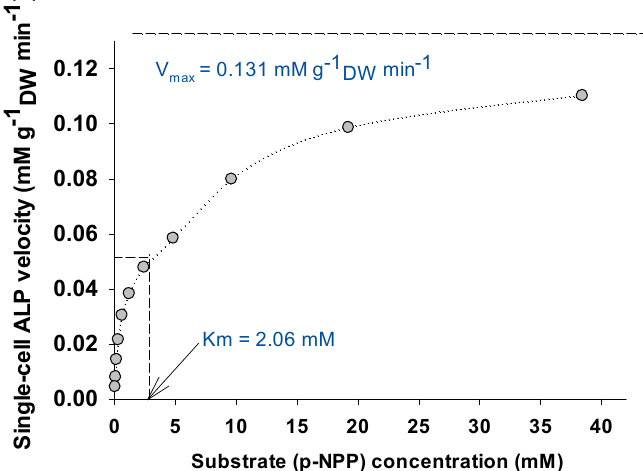
Figure 3. Michaelis–Menten kinetics of A. platensis single-cell enriched in alkaline phosphatase (standard assay conditions: 1 M KCl, pH 12.5, T = 37 °C).